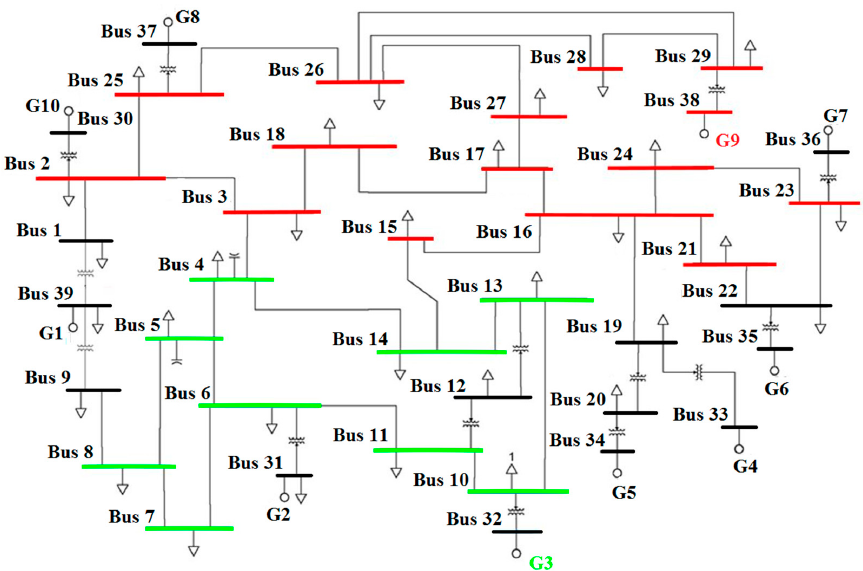
Figure 5. r value changes on dispatch D 1 .